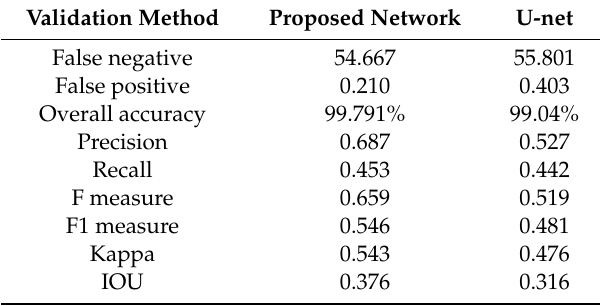
Table 6. Accuracy of the model in the Bangkok area.